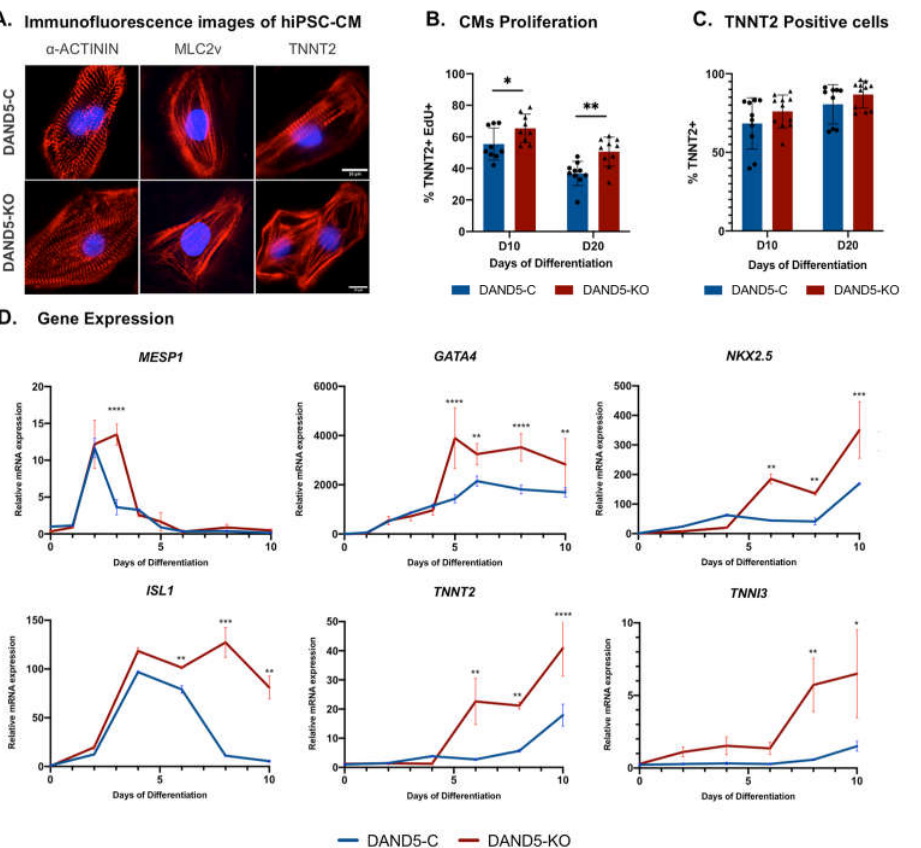
Figure 2. DAND5 depletion leads to higher rates of cardiomyocyte proliferation. ( A ) Representative immunofluorescence images of hiPSC-CM from DAND5-C and DAND5-KO cell lines at day 15 for the CM-specific markers: sarcomeric α -ACTININ, MLC2v, TNNT2 (red). Nuclei were counterstained with DAPI (blue). ( B ) Analysis of TNNT2-positive cell proliferation by labelling newly synthesised DNA using EdU incubation for 17 h using flow cytometry. ( C ) Percentage of TNNT2-positive cells analysed by flow cytometry at day 10 (D10) and 20 (D20) of differentiation. ( D ) Relative mRNA expression of MESP1 , GATA4 , NKX2.5 , ISL1 , TNNT2 , TNNI3 genes in DAND5-C and DAND5-KO differentiated cells. All the results represent the mean ± SD of, at least, three independent biological experiments. Unpaired Student’s t-test was applied to compare the differences between the DAND5-C and DAND5-KO groups on each day of differentiation. Statistically significant results were considered when * p < 0.05, ** p < 0.01, *** p < 0.001 and **** p < 0.0001.